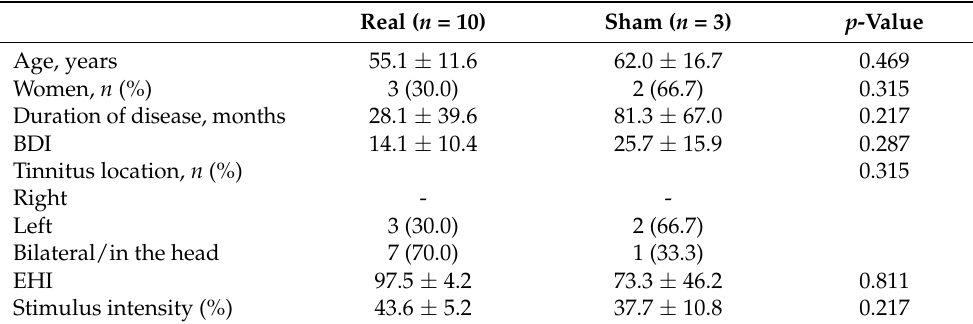
Table 1. Characteristics of patients with